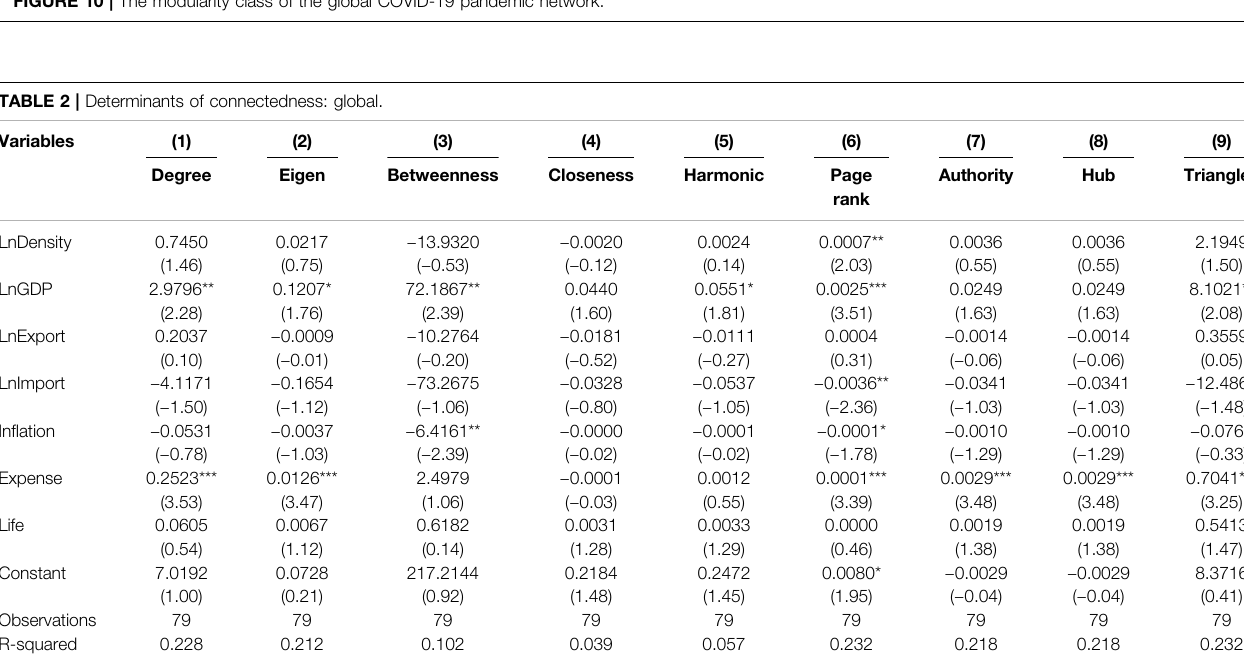
Thistableconstructsregressionmodelsforglobaldeterminantsofconnectedness.Dependentvariablesarenetworkconnectednesscharacteristics.Independentvariablesareeconomic and social factors. Values in parentheses are the T statistical values; ***, **, and * indicate signi fi cance at the levels of 1, 5, and 10%, respectively.